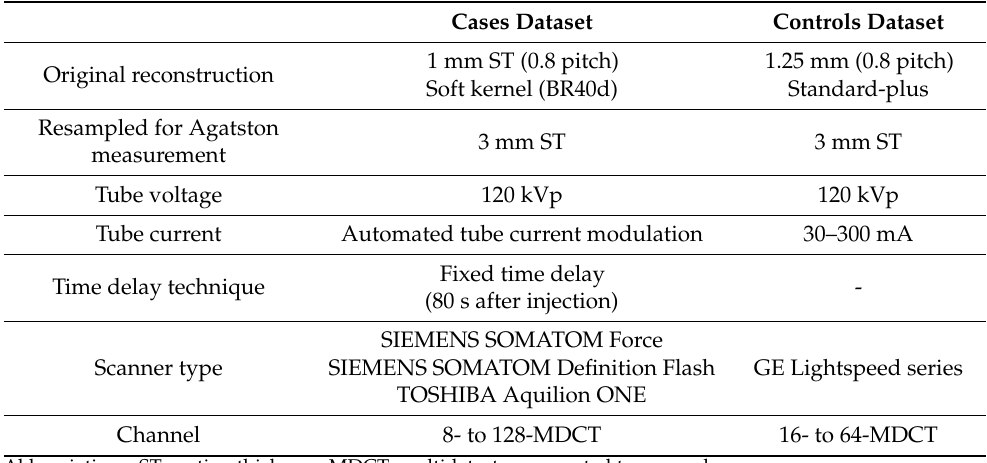
Table 2. Parameters and methods of CT scans.